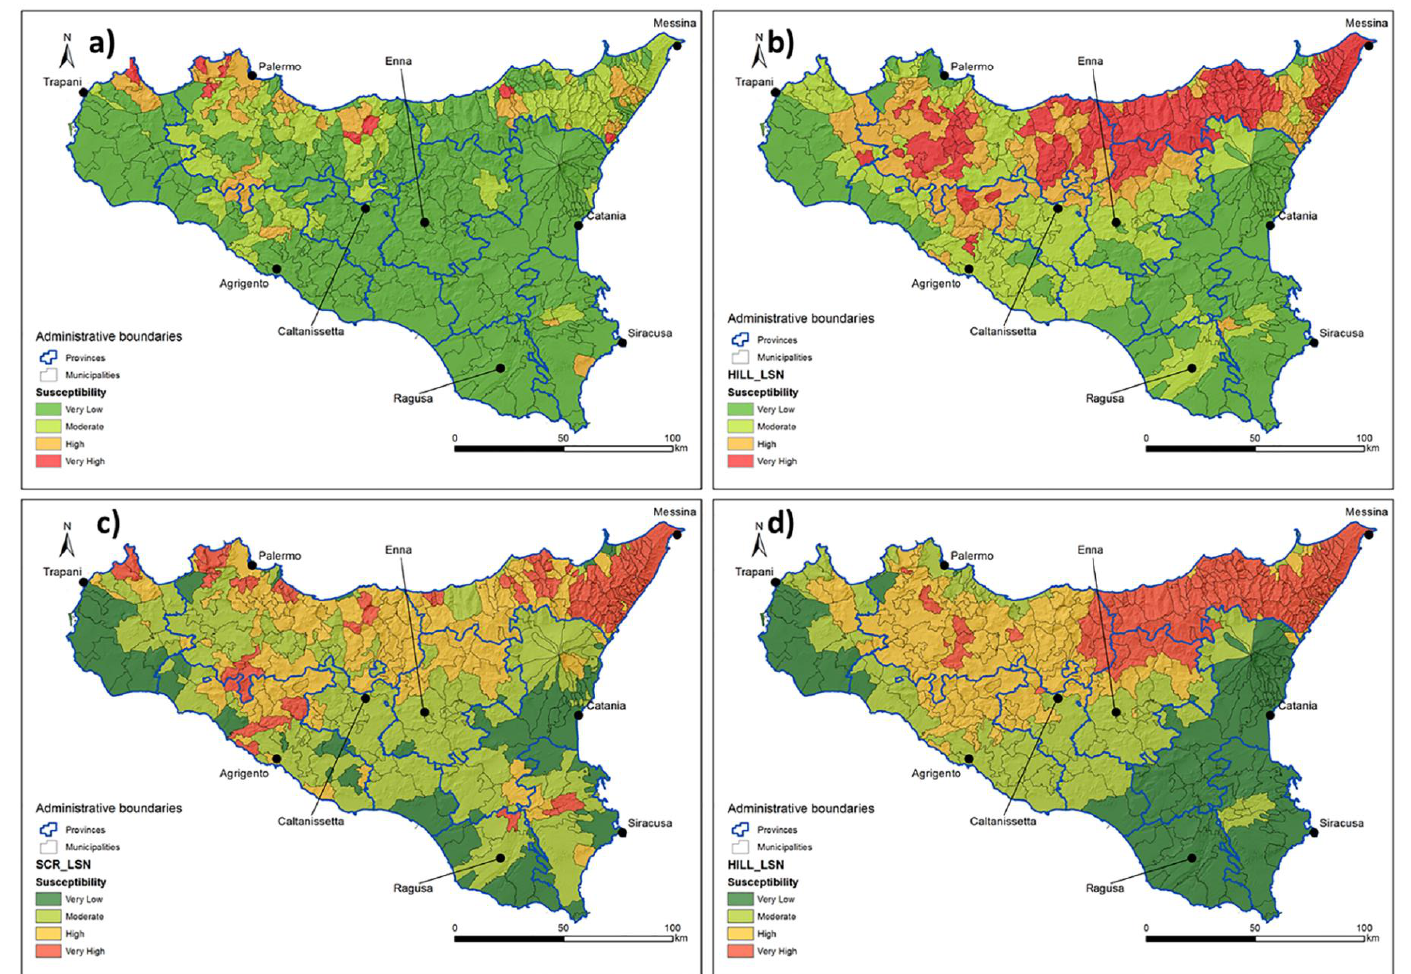
Figure 8. Regional susceptibility map with municipalities boundary. ( a , b ) Using the CA approach for SCR_LSN; ( c , d ) showing the susceptibility classification using the BLR approach.